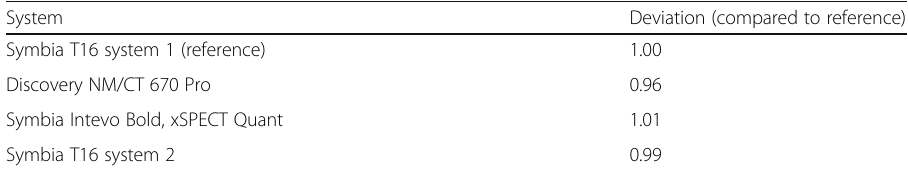
Table 3 Measured differences in activity of a syringe filled with 29.0 MBq 177 Lu resulting from the use of different dose calibrators as used for the given systems System Deviation (compared to reference) Symbia T16 system 1 (reference) Symbia Intevo Bold, xSPECT